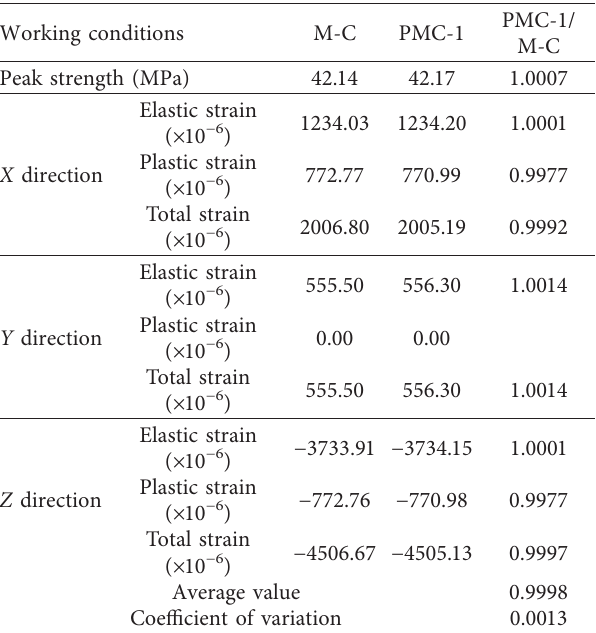
Table 4: Comparison table of numerical simulation results of the true triaxial